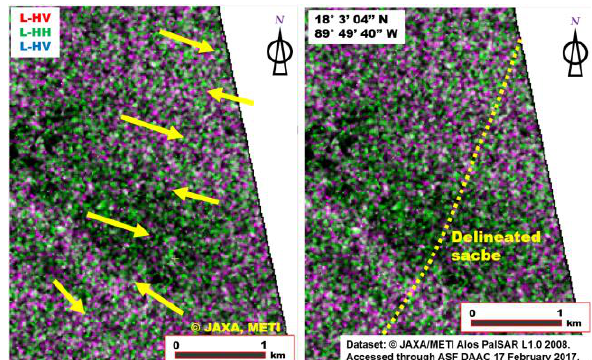
Figure 7. Sacbe segment #7 of Folan et al. (1995) found inside a bajo and surrounding forest area, as displayed on two false-colour composites made with the radar image acquired at the end of the dry season: a) Sentinel-1 (C-VH in red and blue, C-VV in green), and b) Alos-1 PalSAR (L-HV band in red and blue, L-HH band in green).